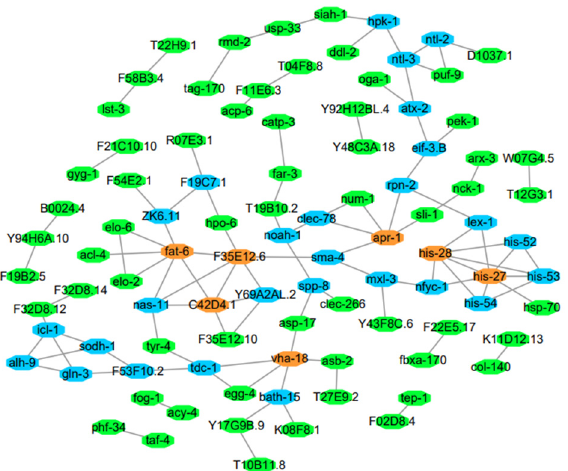
Figure 4. PPI networks of DEGs in C . elegans treated with astaxanthin ( p < 0.05). Genes with degree ≥ 5 (each node had more than five connections/interactions) are shown in orange, degree ≥ 3 but <5 are shown in blue, and degree ≤ 3 are shown in green.